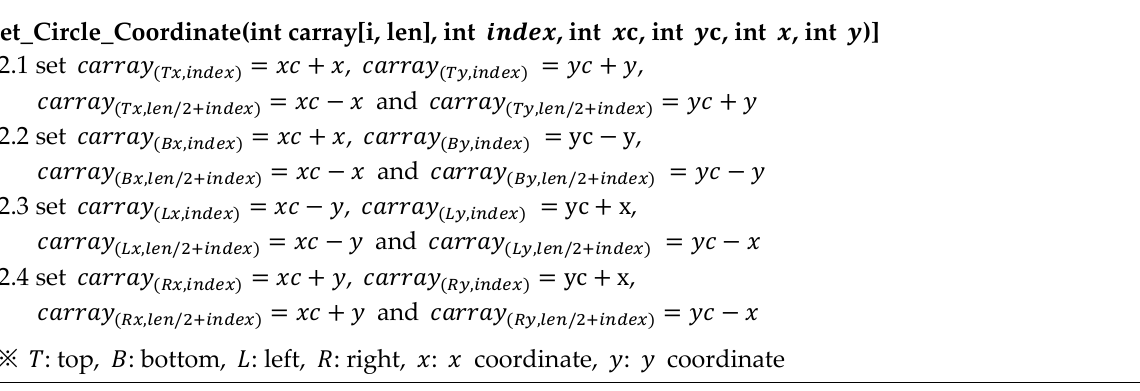
Figure 10. Proposed algorithm (circular coordinate array generation).